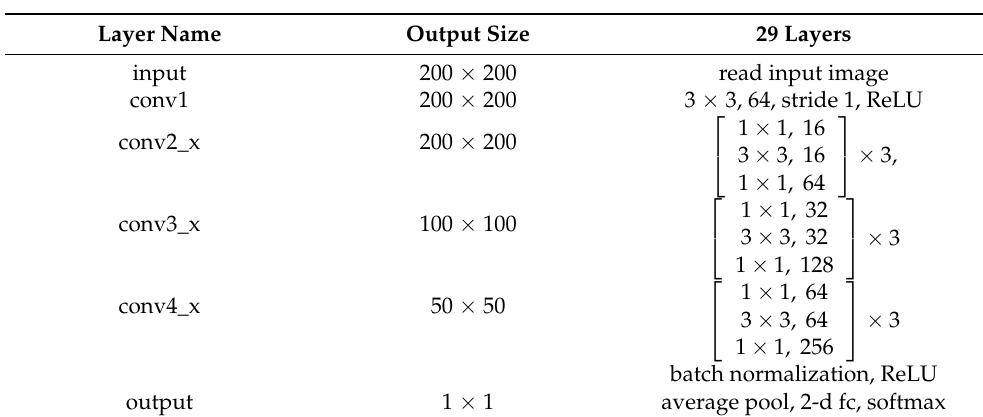
Table 1. Detailed architecture of 29-layers